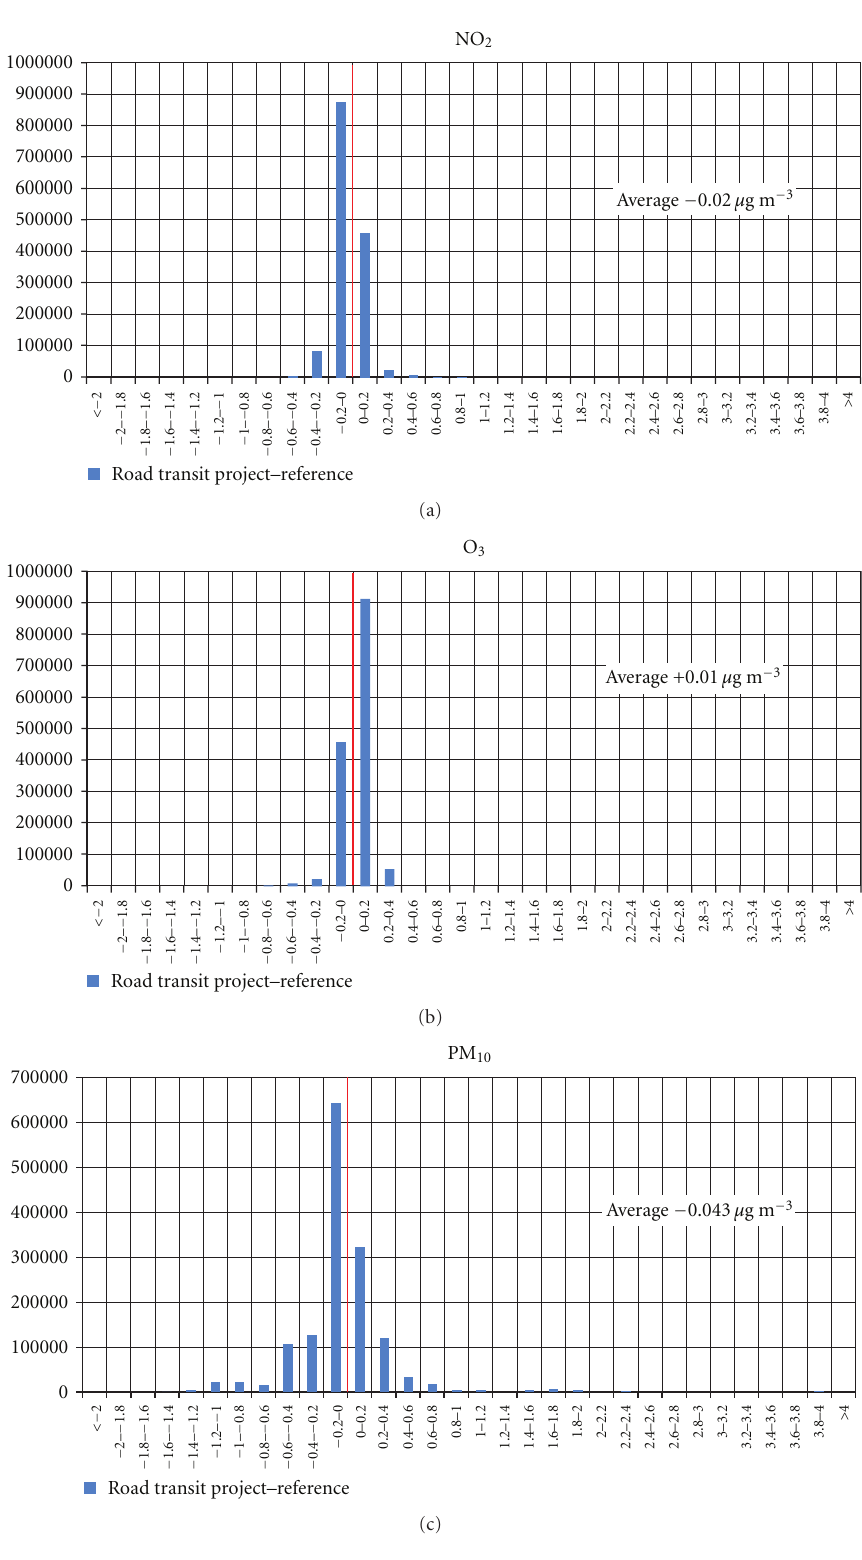
Figure 9: Di ff erences in the number of inhabitants exposed to NO 2 (a), O 3 (b), and PM 10 , (c) concentration levels between “Road transit project”—“Reference”, both scenarios valid for 2030. The red vertical line indicates zero di ff erence. All simulations made with ECHAM5 A1B-r3 and RCP4.5 time varying emissions. Unit x axis: µ gm − 3